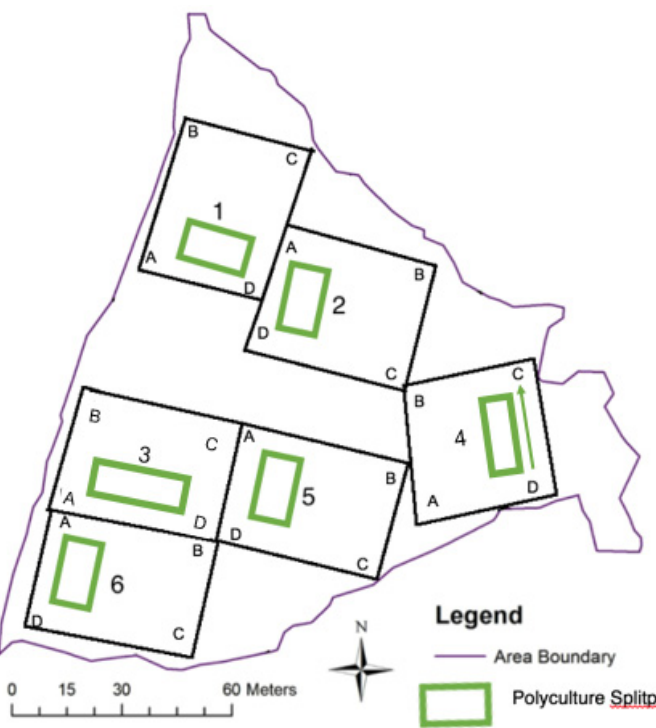
Figure 2. Whole plot (1–6) and subplot configuration of shortleaf pine and loblolly pine monoculture and pine/hardwood polyculture plantings in rehabilitated legacy mined land in eastern Kentucky.